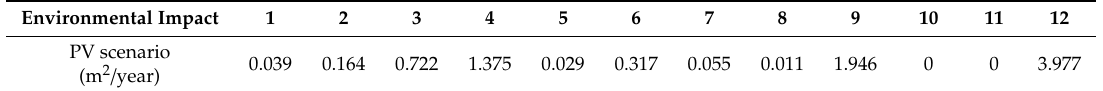
Table 11. Impact of renewable